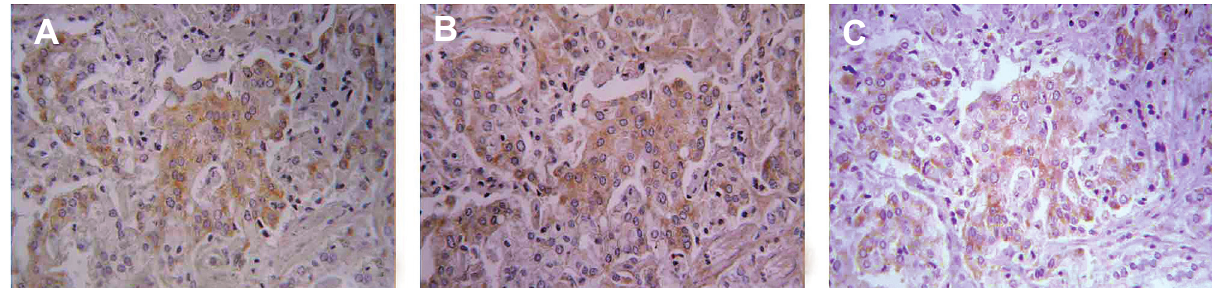
Figure 2 – Sequential slides of a same Gleason-4 prostate cancer, showing high chromogranin-A (A) and Neuro D1 (B) positivity with absent expression of androgen receptor (C). Immunohistochemical staining,